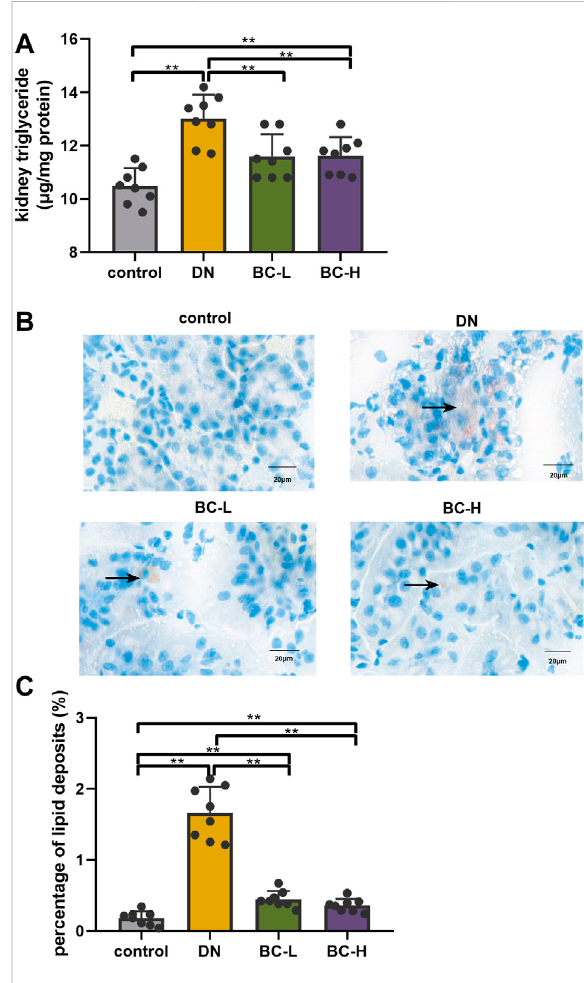
FIGURE 5 BailingCapsulereducedkidneylipidaccumulation. (A) Kidney triglyceride (TG) content. Bailing Capsule reduced kidney TG contents in DN rats. (B) Lipid droplets were detected by Oil Red O staining (400 X). Bailing Capsule reduced the percentage of lipid deposits in DN rats. Black arrow showed the lipid droplets. Scale bar = 20 μ m. (C) The quanti fi cation of percentage of lipid deposits. DN, diabetic nephropathy; BC-L, low dosage of Bailing Capsule; BC-H, high dosage of Bailing Capsule. Data are expressed as mean ± SD ( n = 8). ** p <